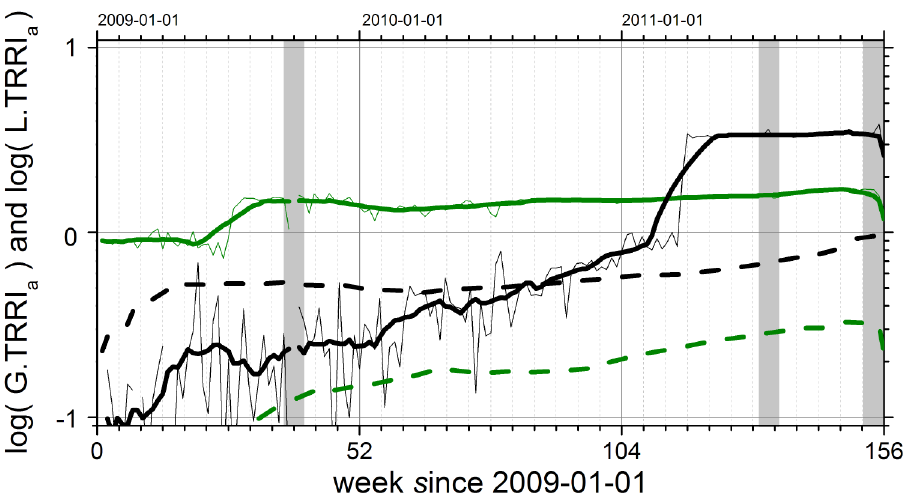
Fig 4. Project life cycle phases derived from Wikipedia usage data based on L.TRRI a ( t ) (straight lines, Eq (5)) and G.TRRI a ( t ) (dashed lines, Eq (6)) for Apache Hadoop (black) and Apache SOLR (green) versus time in weeks since 2009-01-01. For Hadoop L.TRRI a ( t ) we find a strong linear increasing trend with some short-term fluctuations fading out after three months in the years 2009 and 2010. These short-term peaks reflect conference seasons. In 2011, finally, L.TRRI a ( t ) gets greater than one: a sporadic jump in the user interest is followed by a saturation. G.TRRI a ( t ) shows a significantly weaker trend during the same time and remains below one. This means that public interest in Hadoop related information is bound to the English language. The ‘ break through ’ of Apache Hadoop as a relevant topic is thus in 2011, about 18 months after Apache SOLR became a relevant topic. However, finally Apache SOLR is less relevant than Apache Hadoop. The gray areas indicate times for which no data was available for technical reasons. While the thin lines are the original L.TRRI a ( t ) data, the thick lines have been obtained by applying a running average filter with a window length of 12